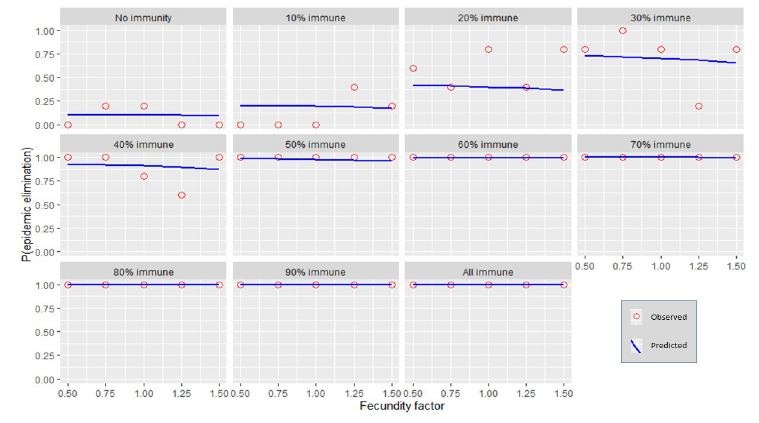
Fig 3. The response of P(elim.) to the fecundity factor at different herd immunities. The proportion of elimination events from the transmission model (red circles) and the prediction from the regression model (blue